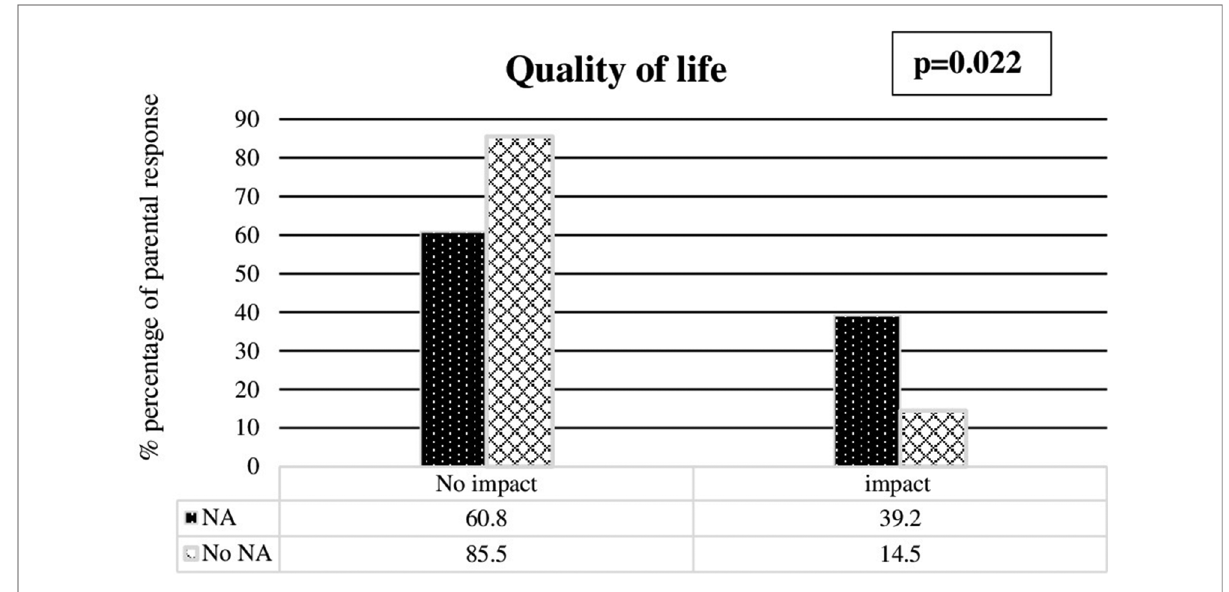
FIGURE 3 Impact of neurodevelopment at 8 years old on the quality of life scores of the